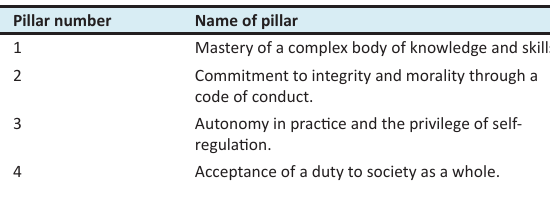
FIGURE 1: The four pillars of